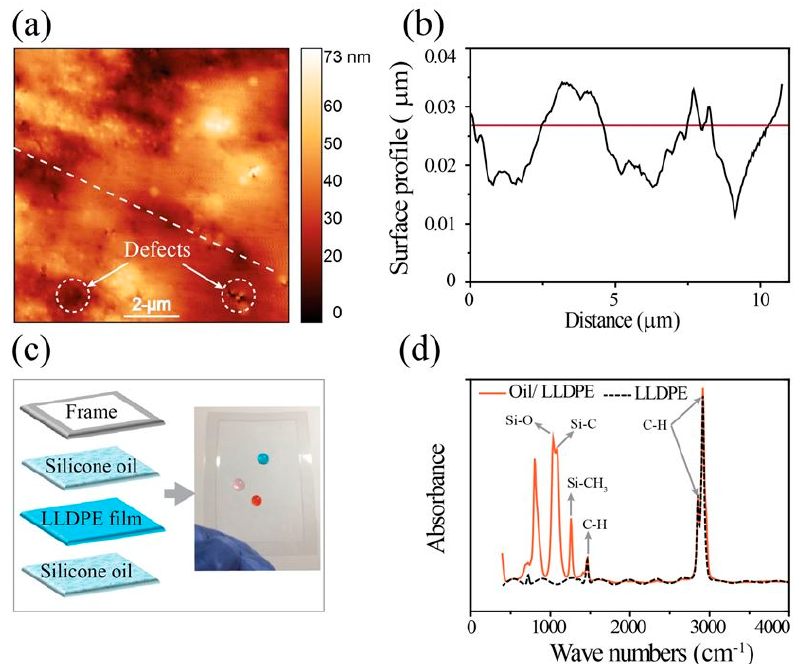
Figure 3. Surface morphology of the commercial LLDPE film. ( a ) Atomic force microscopy (AFM) image of the film and ( b ) representative surface profile extracted from (a) at the dashed line. ( c ) Schematic structure of a dielectric film prepared for the paper-based DMF chip and a photograph of the prepared dielectric film with three colorful drops on it. ( d ) FT-IR spectrum of a LLDPE-dielectric film with and without a silicone oil coated.